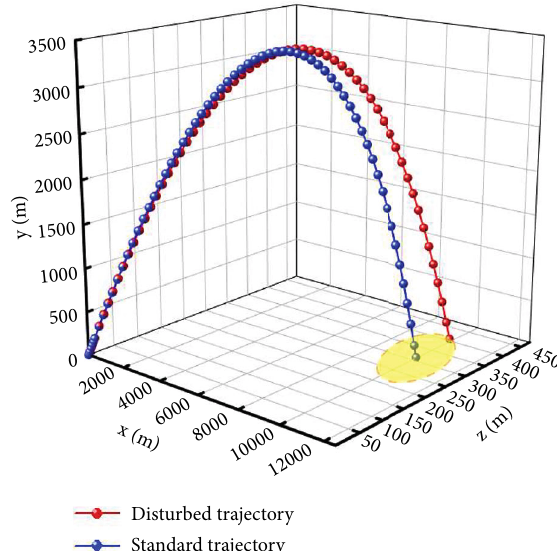
Figure 7: Trajectory comparison of the projectile with or without disturbance.